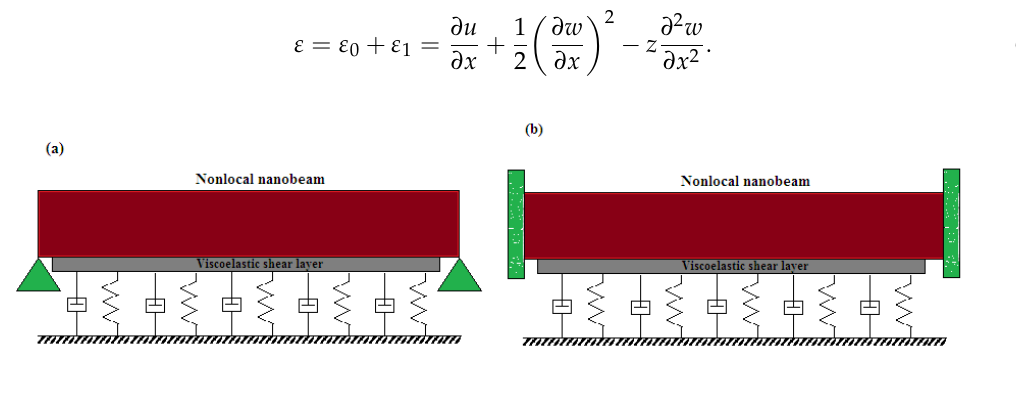
Figure 1. Boundary conditions for different beam supports. ( a ) Simple-simple case and ( b ) clamped-clamped